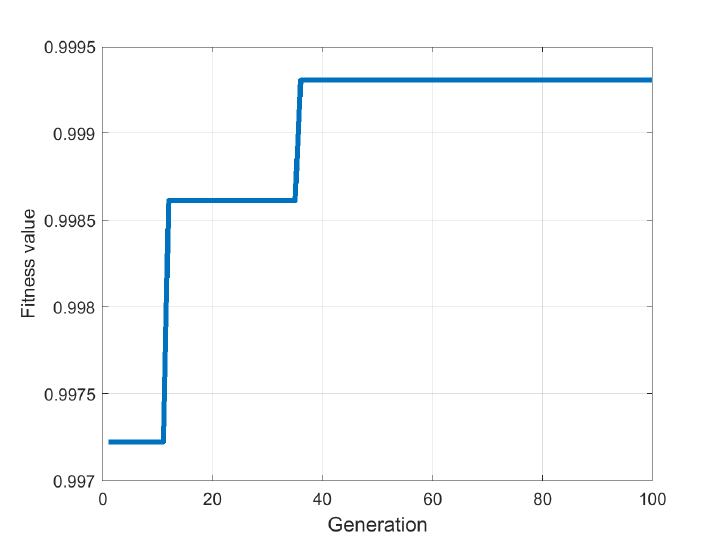
Figure 4. Variation of the best fitness values per generations number for RFI classification application using two